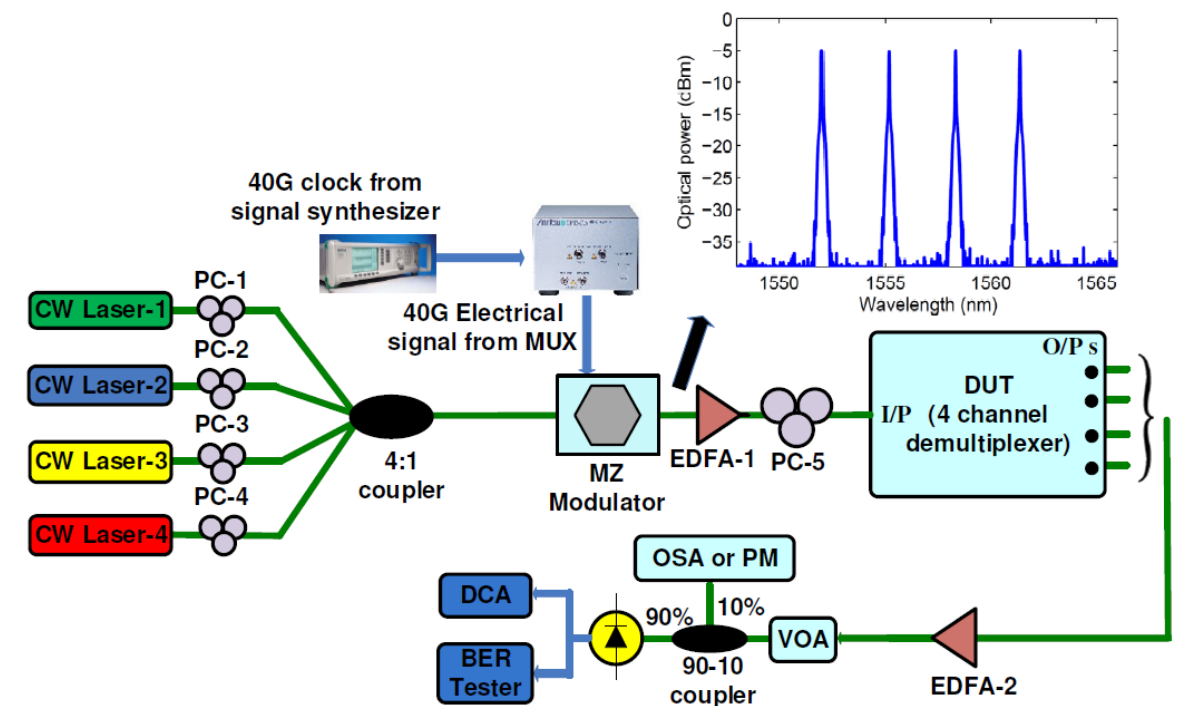
Figure 13. Experimental setup to capture eye diagrams and to evaluate BER performance of the optical demultiplexer. EDFA: Erbium doped fiber amplifier, PM: power meter, OSA: Optical spectrum analyzer, DCA: digital communication analyzer. Inset shows the optical spectrum of the four modulated